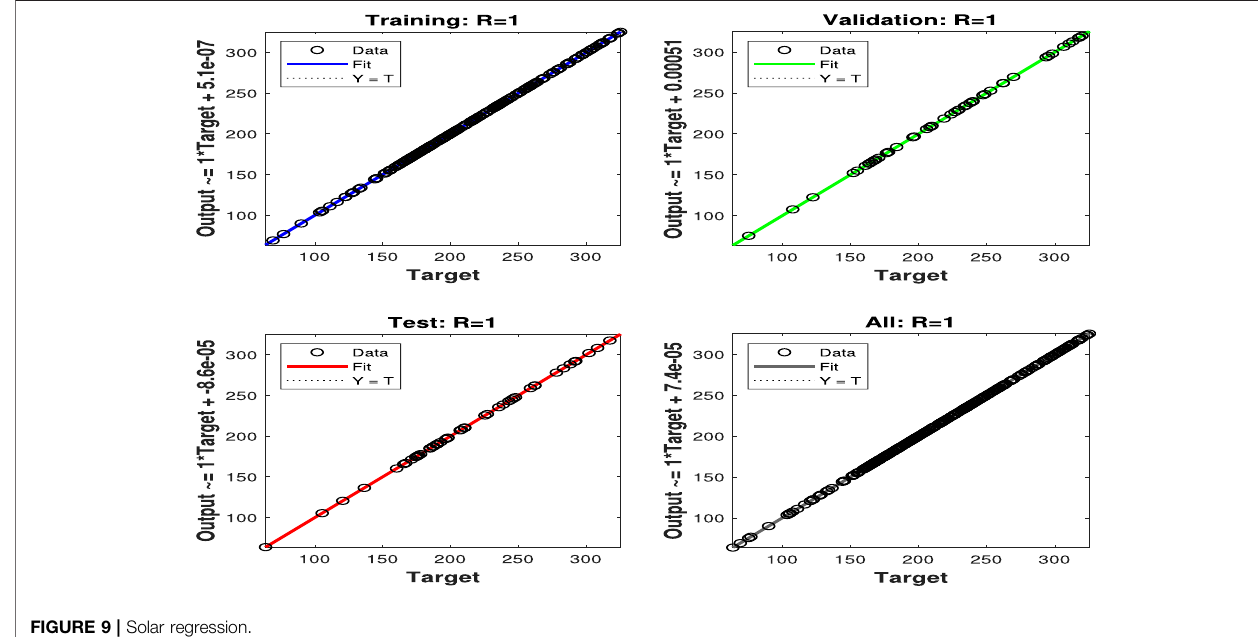
FIGURE 9 | Solar regression.